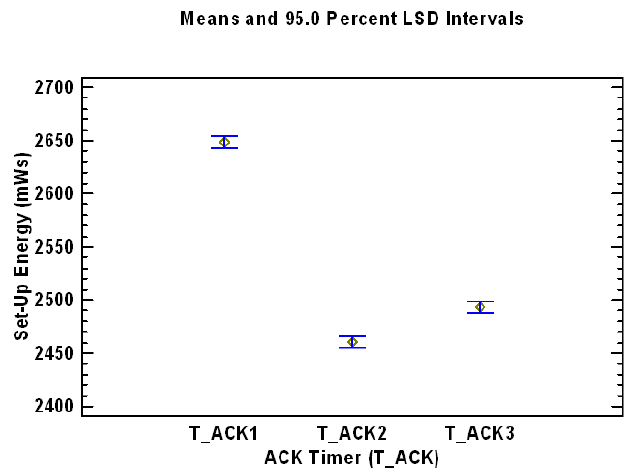
Figure 9. Mean values of the levels of the factor ACK Timer factor, analyzing the dependent variable Set-Up Energy (mWs).